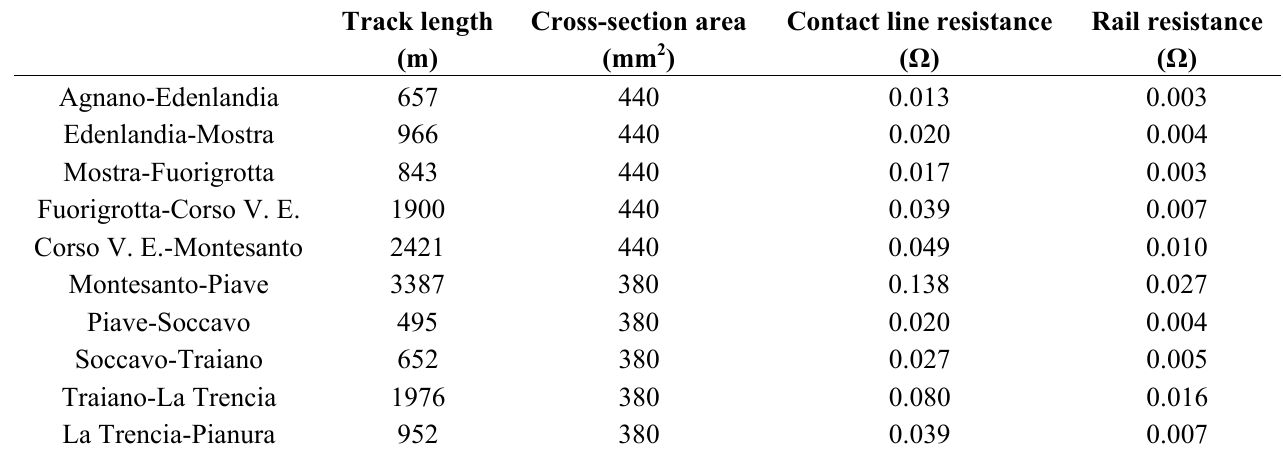
Table 2. Characteristics of the Agnano-Pianura branch.